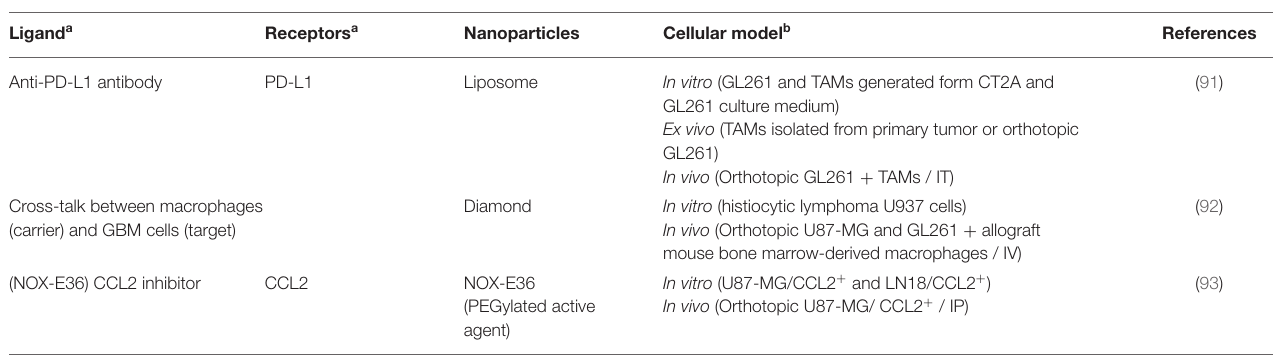
TABLE 3 | Selection of ligands for tumor-associated myeloid cell targeting, with the corresponding